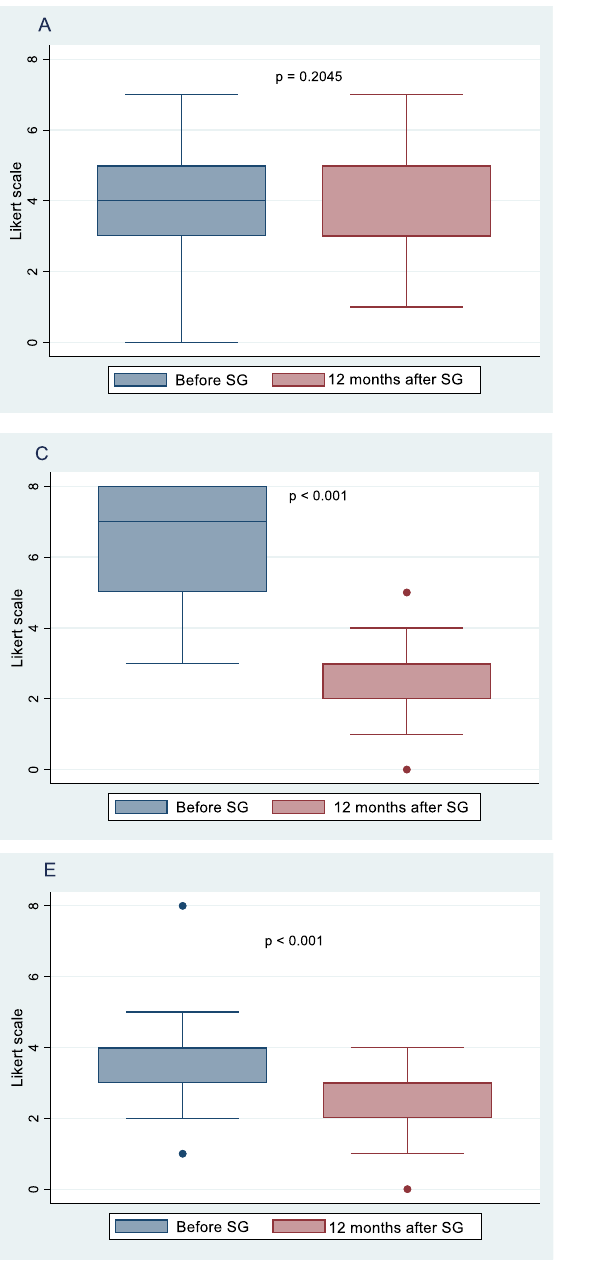
Figure 1. Food intake frequency before sleeve gastrectomy (SG) and after 10 months follow-up. Change in the frequency of meat and fish consumption in females ( A ), and males ( B ); change in the frequency of bread and crackers consumption in females ( C ), and males ( D ); change in the frequency of dairy products and fats consumption in females ( E ), and males ( F ).